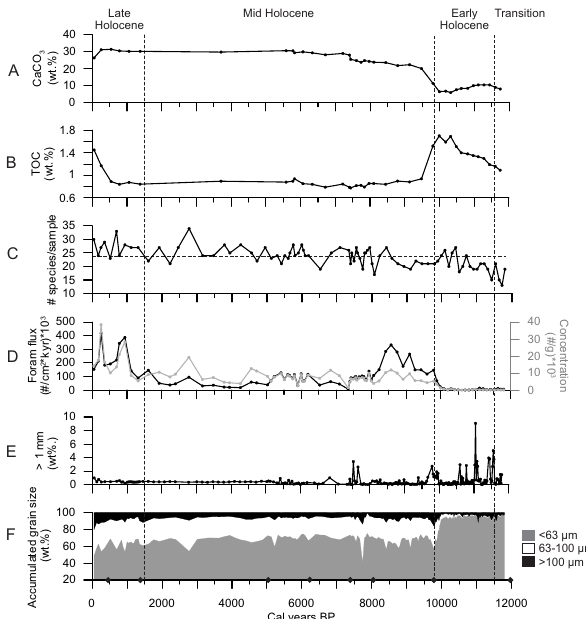
Fig. 3. Sediment properties of core JM09-KA11-GC. (A) CaCO 3 as weight percentage. (B) TOC as weight percentage. (C) Num- ber of benthic species per sample with dashed line indicating aver- age value. (D) Benthic foraminiferal flux (left, black) together with foraminiferal concentration (right, grey). (E) Size fraction > 1mm is considered as ice rafted debris (IRD). (F) Accumulated grain size as weight percentage. Black diamonds on x axis indicate calibrated age